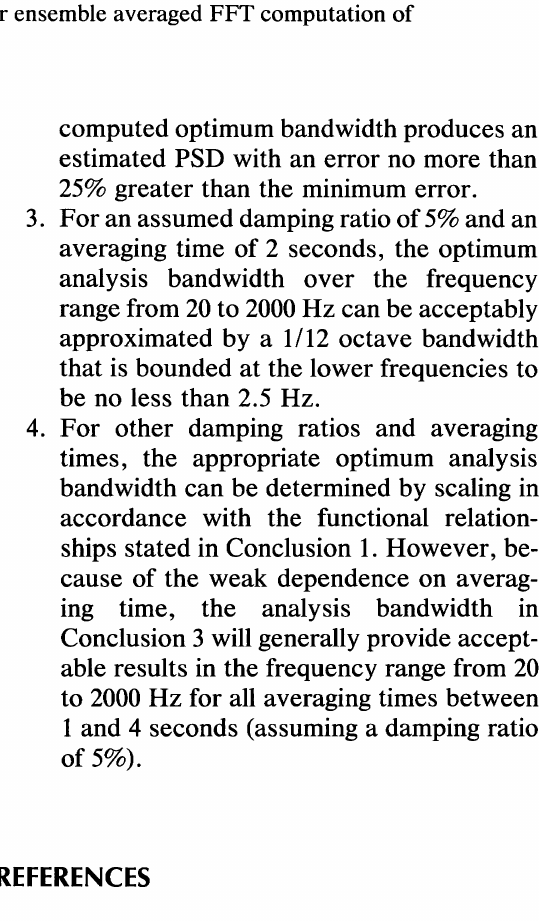
FIGURE 8 Frequency resolution bias errors for ensemble averaged FFT computation of random vibration signal PSD